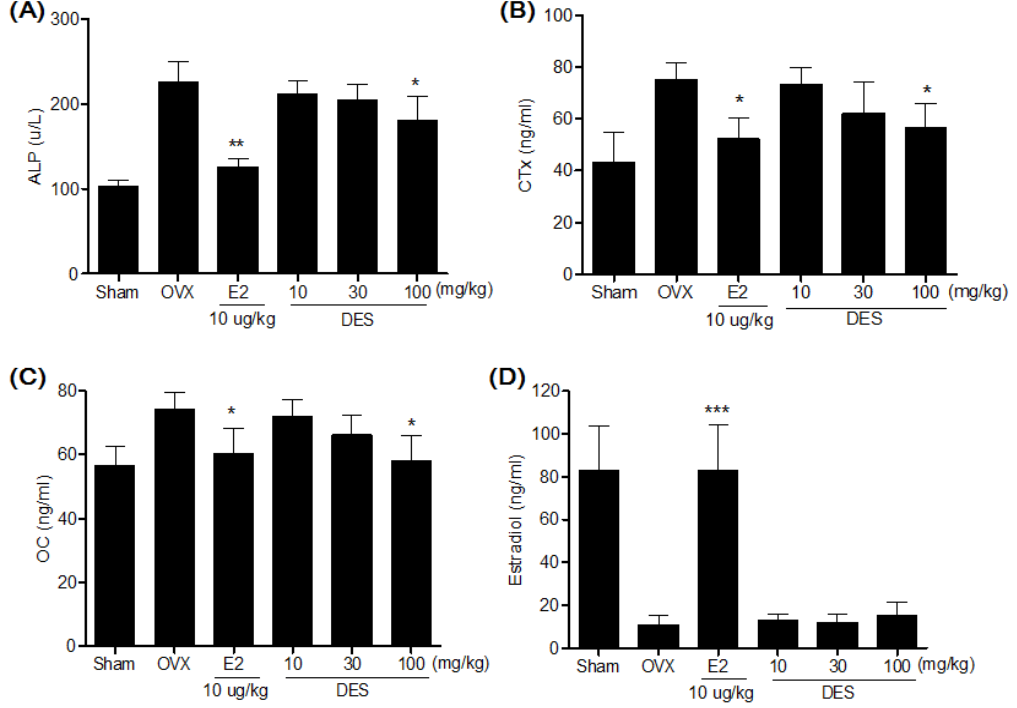
Figure 5. Effects of DES on serum ALP ( A ), CTx ( B ), OC ( C ) and estradiol ( D ) concentrations. Data are mean ± SD values (n = 10 per group). * p < 0.05, ** p < 0.01, *** p < 0.001, significantly difference from the OVX-control